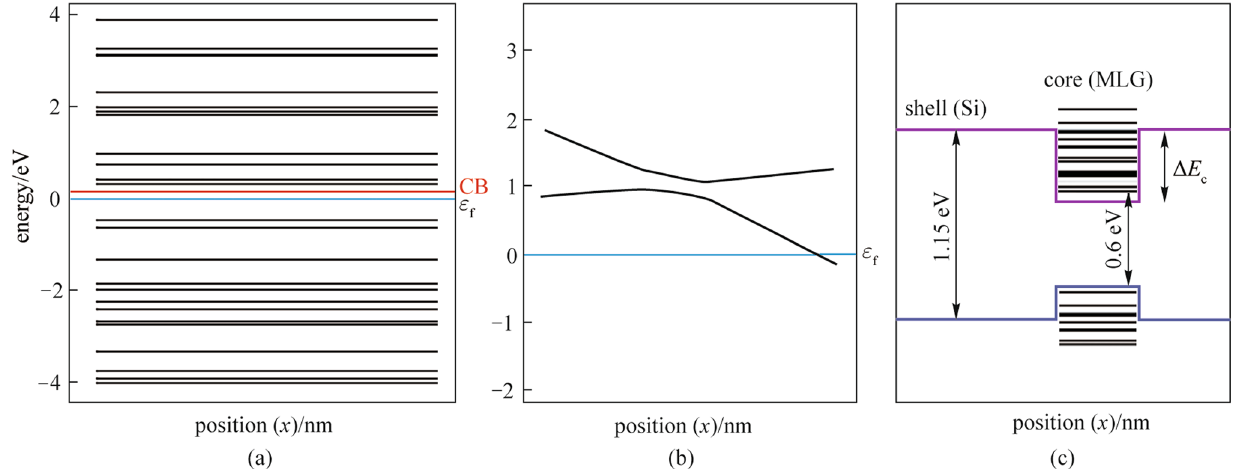
Fig. 4 a Bound state energy levels for the single graphene/Si QD; b effect of the strain on the energy levels of graphene/Si QD; c calculated band alignment for the graphene/Si